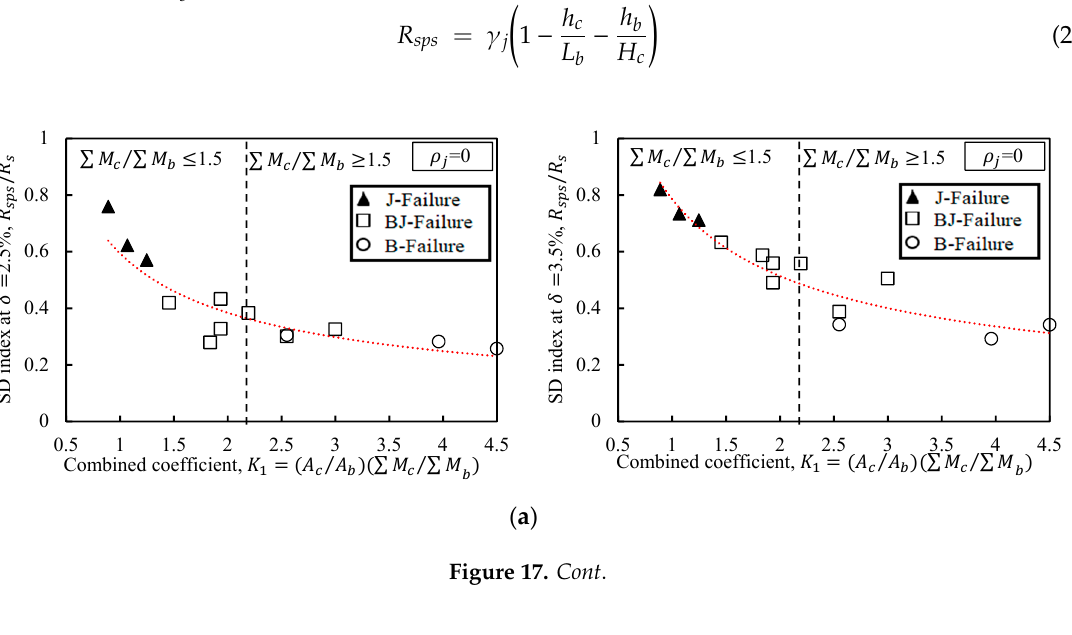
Figure 16. Maximum shear stress at the interior joints for different combinations of design